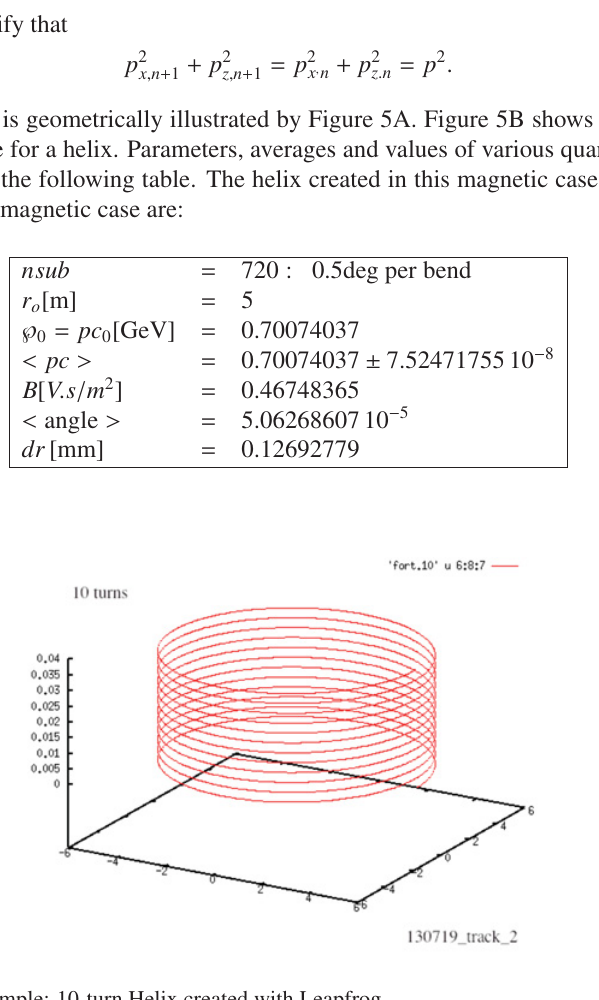
Figure 6. Magnetic example: 10-turn Helix created with